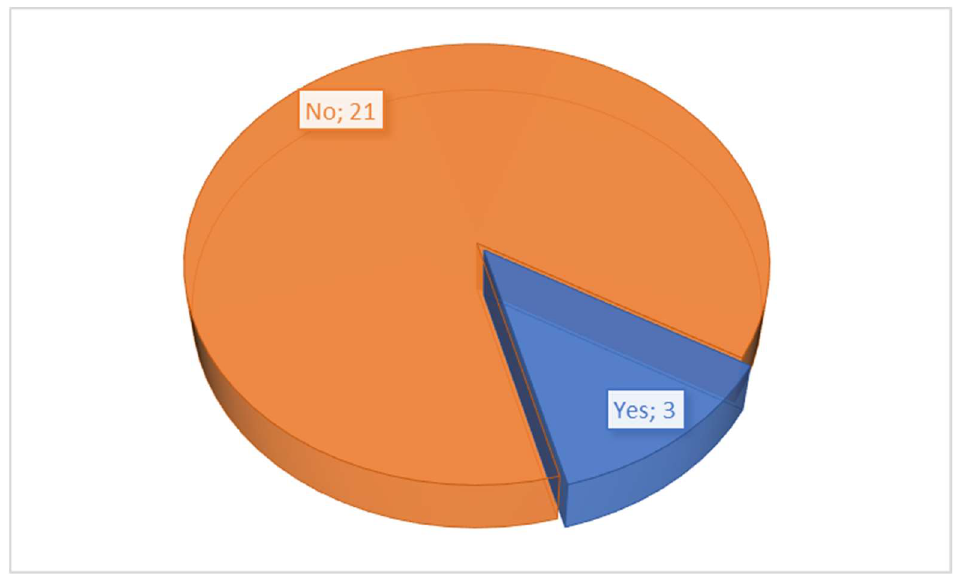
Figure 11. Transparency operators of shared mobility services.